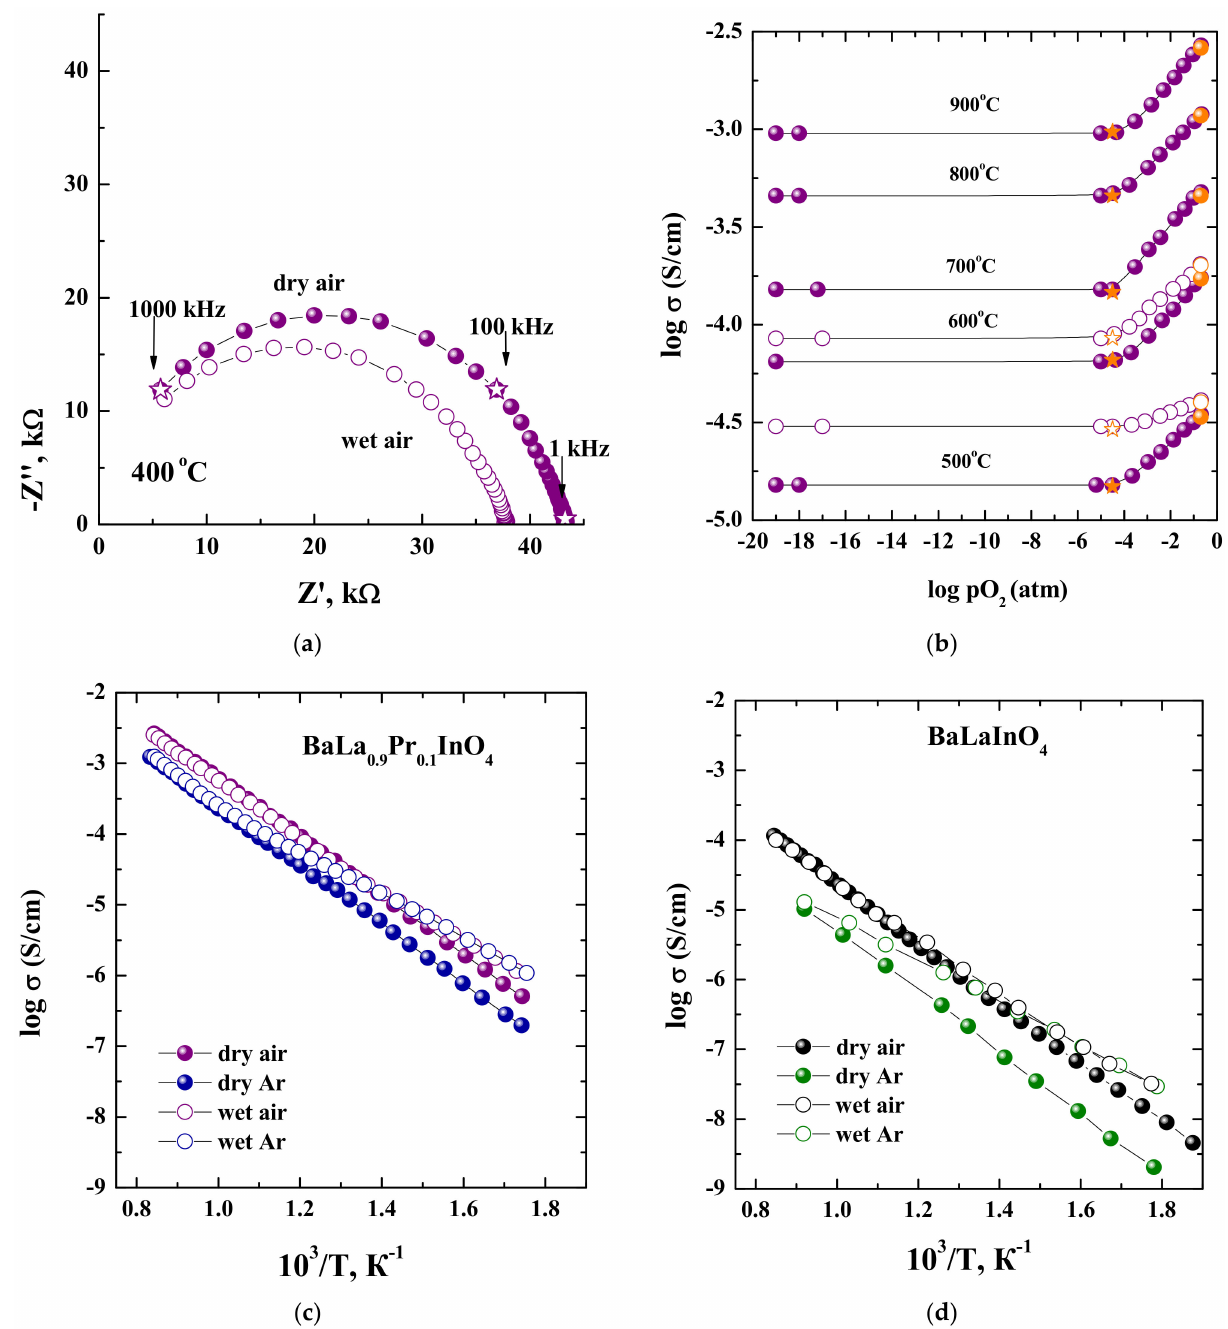
Figure 3. The Nyquist plots for the composition BaLa 0.9 Pr 0.1 InO 4 obtained under dry and wet air at 400 ◦ C ( a ), the dependencies σ – pO 2 for the composition BaLa 0.9 Pr 0.1 InO 4 (violet symbols) at dry (closed symbols) and wet (open symbols) atmospheres ( b ), the dependencies σ –1000/T for the compositions BaLa 0.9 Pr 0.1 InO 4 ( c ) and BaLaInO 4 [56] ( d